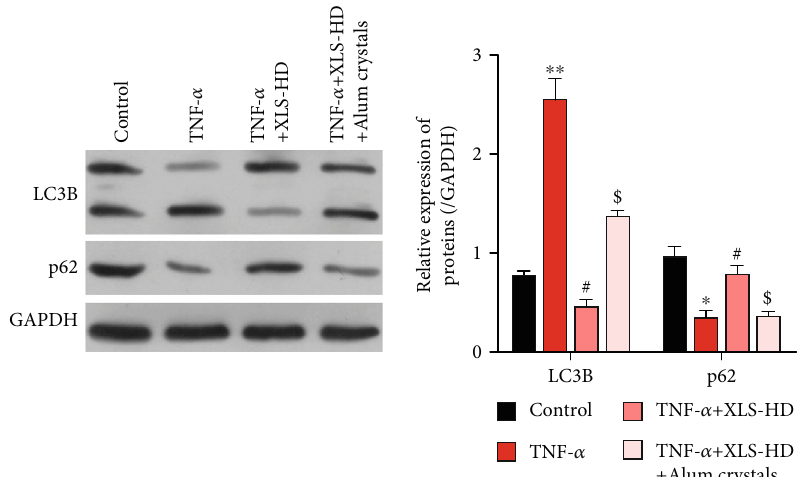
Figure 6: Xi Lei San reversed autophagy in rats with DSS-induced colitis. ∗ P < 0 : 05 and ∗∗ P < 0 : 01 vs. the control group; # P < 0 : 05 vs. the TNF- α group; $ P < 0 : 05 vs. the TNF- α +Xi Lei San